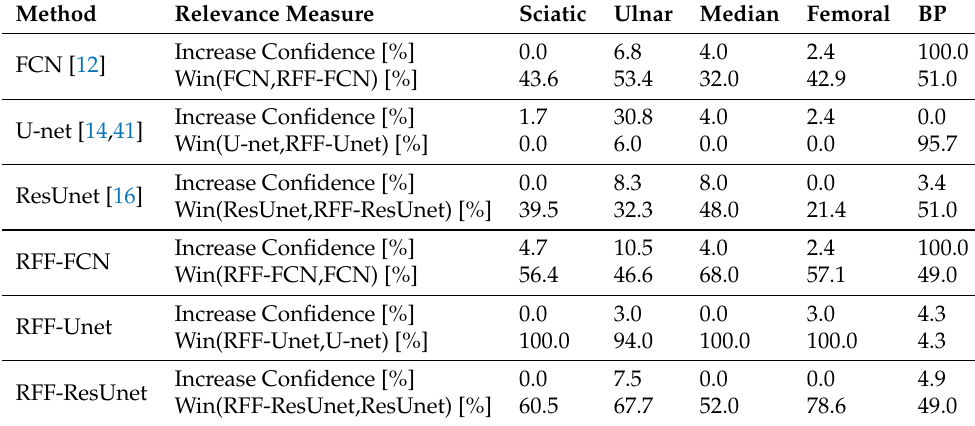
Figure 9. Region of interest-based relevance analysis results for ResUnet and RFF-ResUnet ap- proaches (Nerve-UTP and NSD datasets). Red contour: median target segmentation region (rescaled and centered for visualization) along with the testing set instances. Heatmaps are presented on a Jet colormap scale, where the blue color stands for low relevance, yellow for medium relevance, and red for high relevance. Table 4. Relevance analysis results based on class-conditional score measures (the increase confidence and Win-based assessments are reported for Nerve-UTP and NSD datasets). The sciatic, ulnar, femoral, and median nerve segmentation results for Nerve-UTP, and the brachial plexus (BP) for NSD are considered. Win( M ,RFF- M ) is shown, where Win(RFF- M , M ) = 100-Win( M ,RFF- M